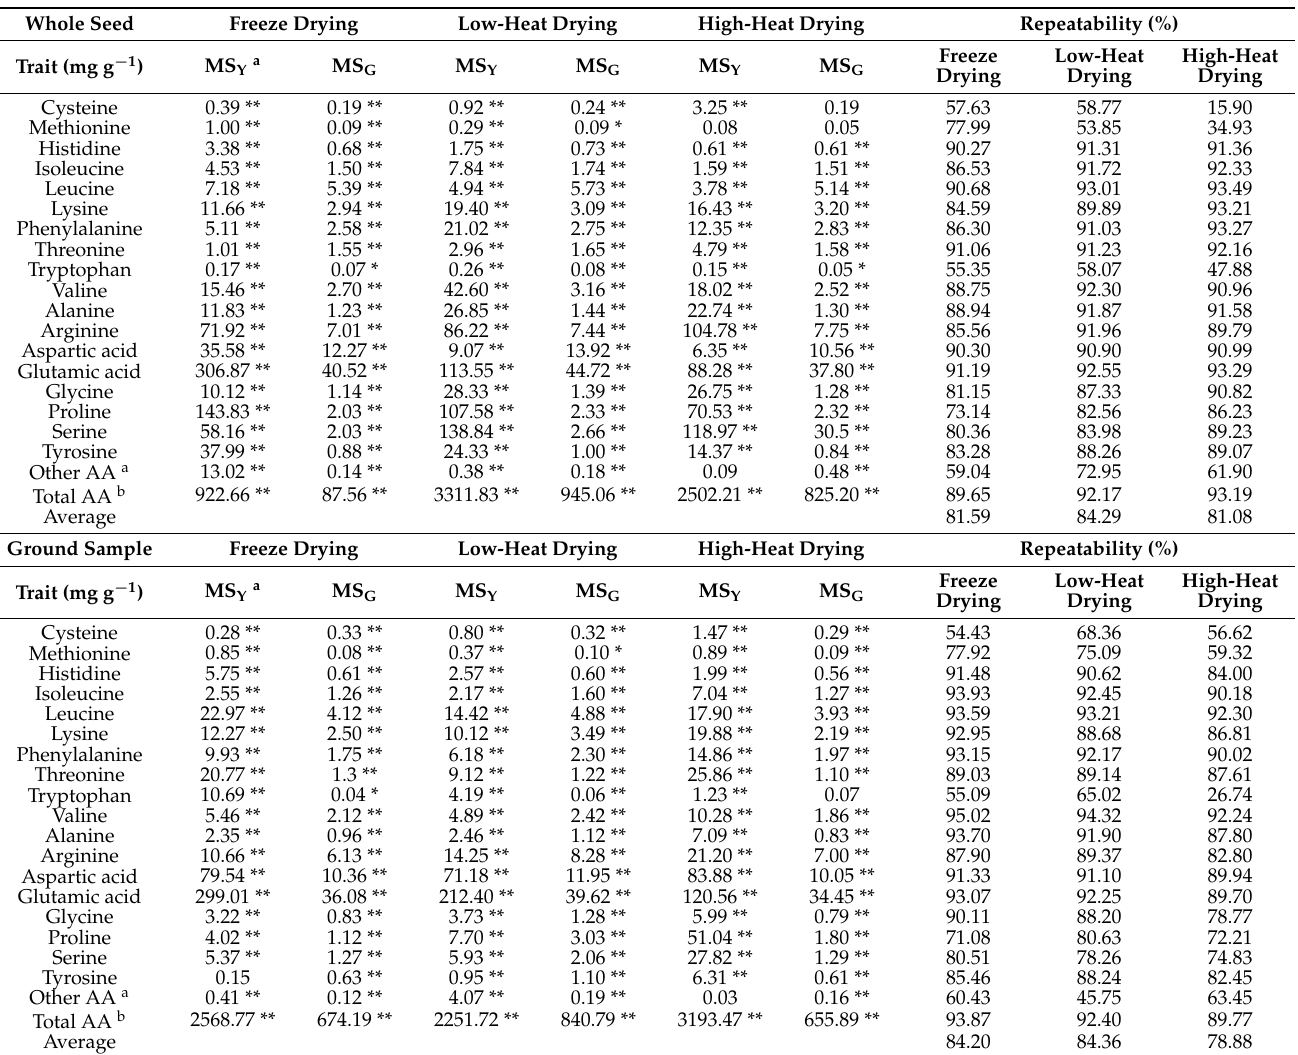
Table 5. Mean squares from ANOVA and estimates of repeatability of amino acid traits for edamame drying methods with whole seed and ground